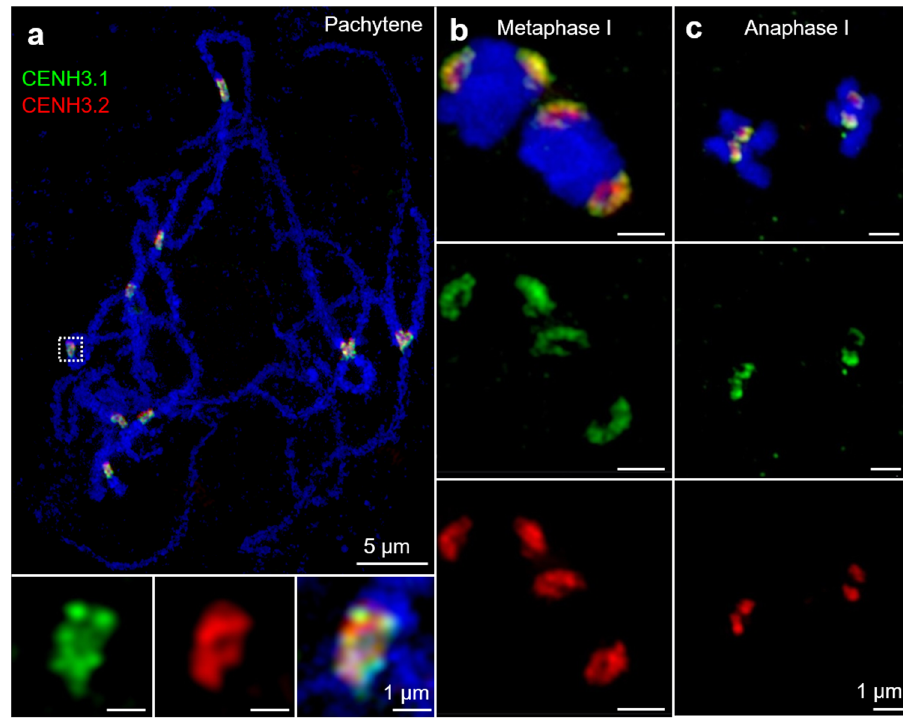
Fig. 4 The organization of cowpea centromeres during male meiosis analyzed by indirect immunostaining and structured illumination microscopy (SIM). a Both CENH3.1 (green) and CENH3.2 (red) occupy the centromeres at pachytene, b metaphase l and c anaphase l of pollen mother cells. Further enlarged centromere regions of pachytene chromosomes are shown